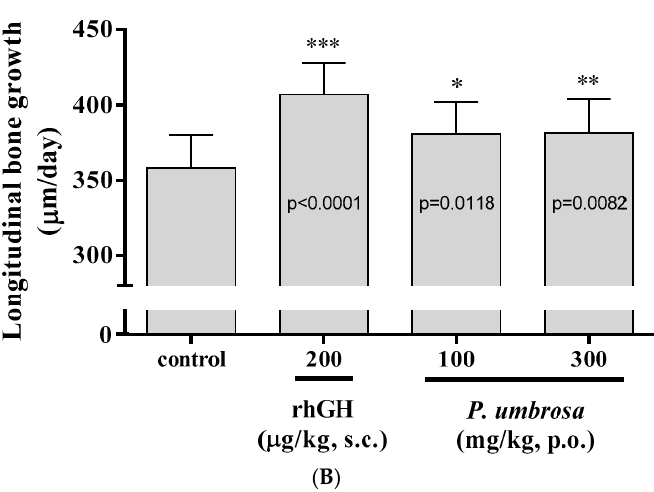
Figure 2. ( A ) Representative fluorescence photomicrographs of sagittal sections of the proximal tibial growth plate in rats. The double-headed arrow shows the distance between the chondro-osseous junction within the growth plate and the proximal endpoint of the tetracycline label which indicates the length of bone growth in proximal tibial growth plate during 72 h period. ( a ) vehicle treated control group; ( b ) rhGH 200 μ g/kg (s.c.) treated group; ( c ) P. umbrosa 100 mg/kg (p.o.) treated group; ( d ) P. umbrosa 300 mg/kg (p.o.) treated group. The scale bar is 200 μ m; ( B ) Effects of P. umbrosa on longitudinal bone growth rate in proximal tibial growth plate. Each value is the mean ± SD. The number of animals is 14-21 per group; * p < 0.05, ** p < 0.01 and *** p < 0.001 vs. control (one-way ANOVA, Bonferroni test).